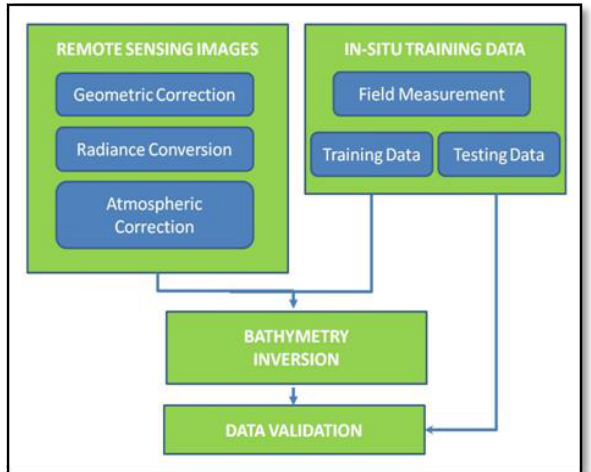
Figure 5. Flow chart of imagery-derived bathymetry.